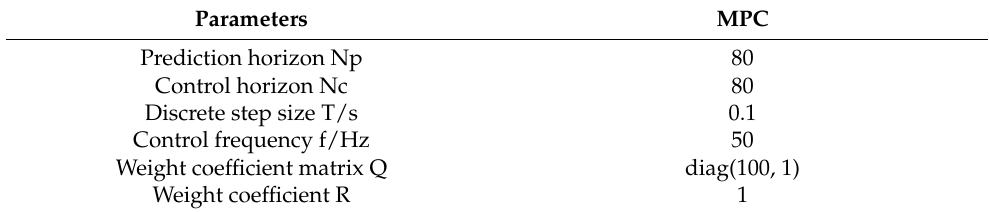
Table 2. Controller parameters.